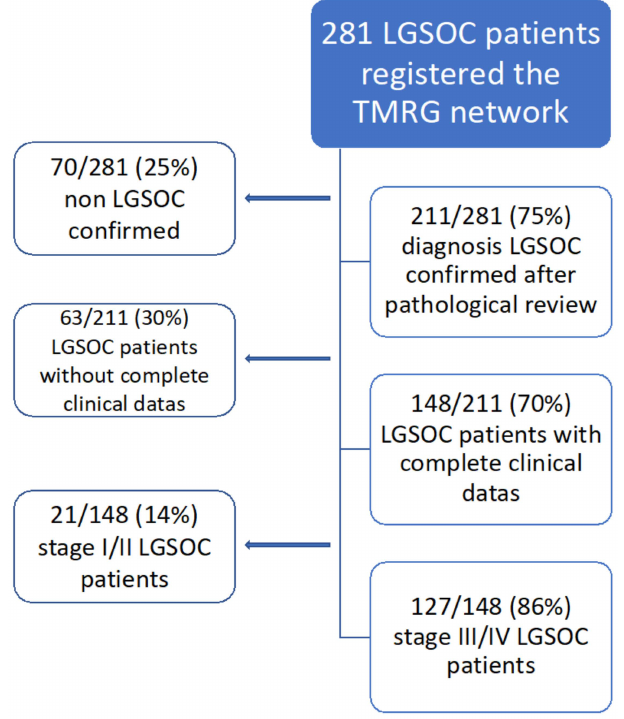
Figure 1. Flowchart of the